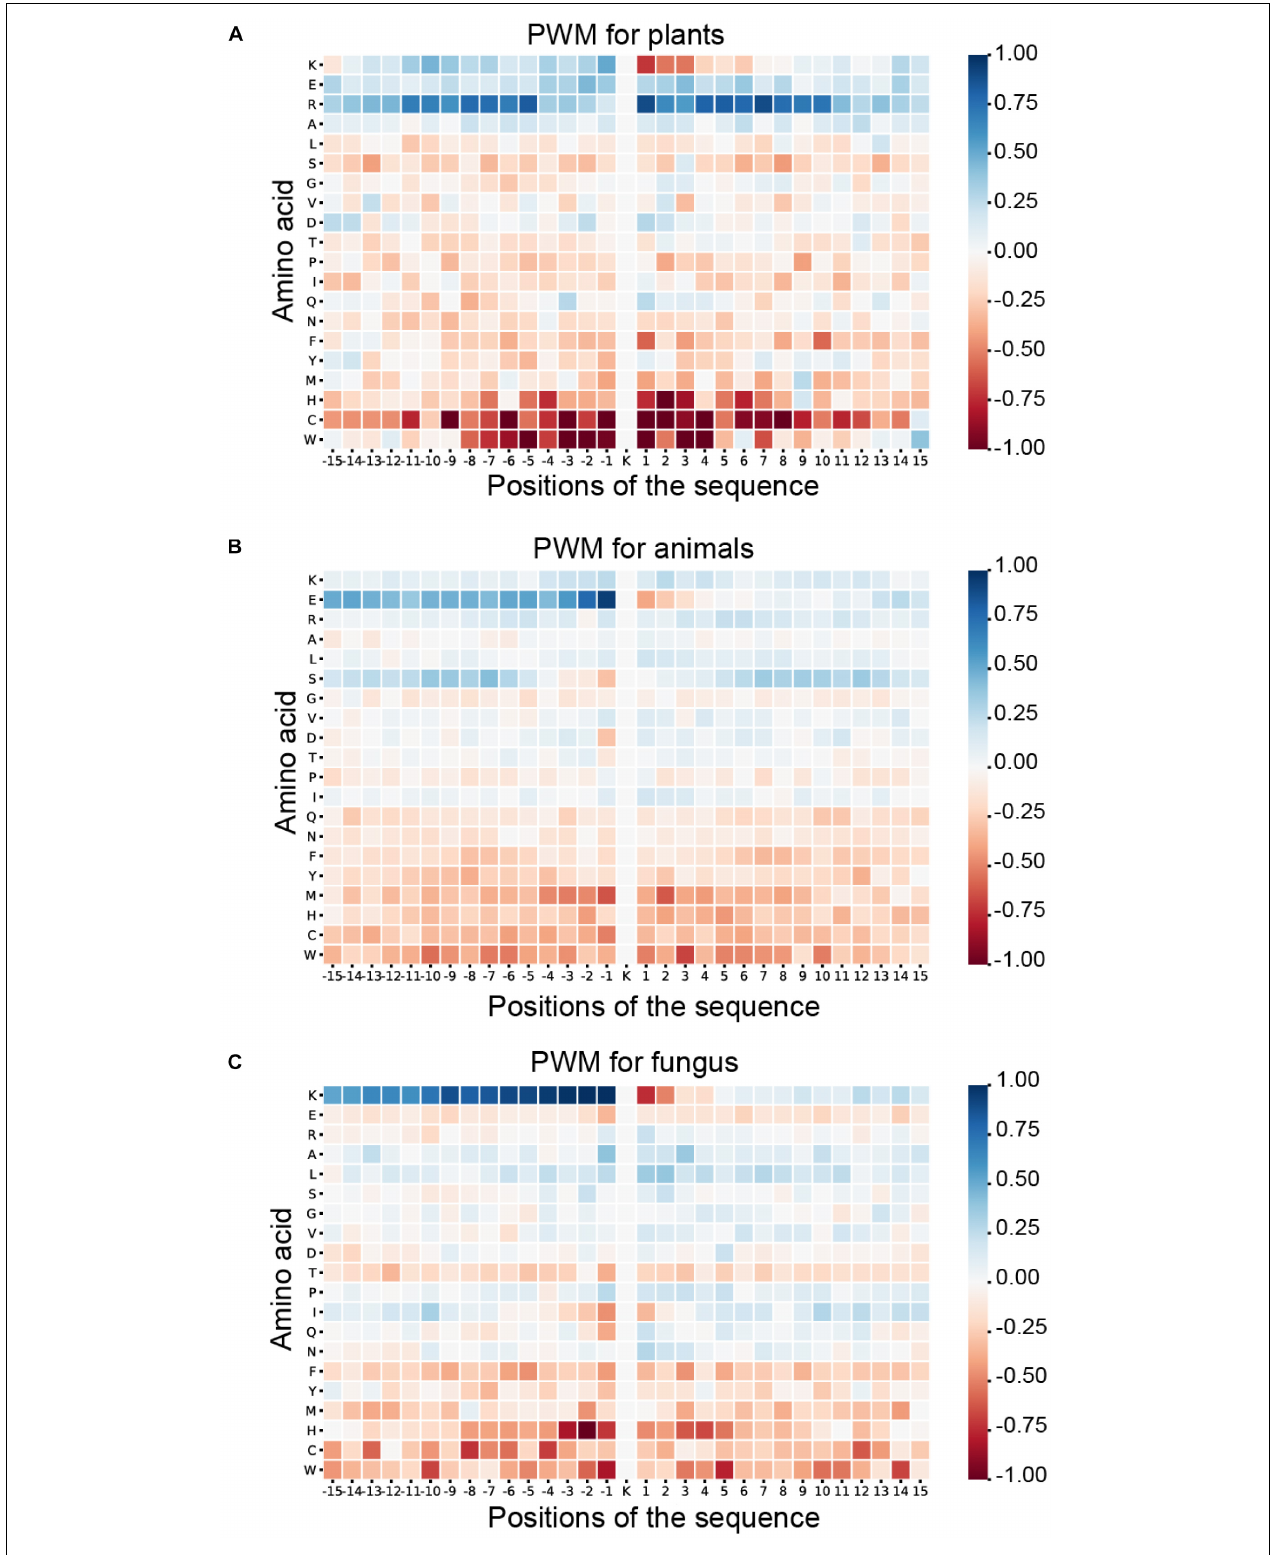
FIGURE 6 | Heatmaps for the positional weighted matrix (PWM) features of three species. (A) Heatmaps for the PWM features of plants. (B) Heatmaps for the PWM features of animals. (C) Heatmaps for the PWM features of fungi.